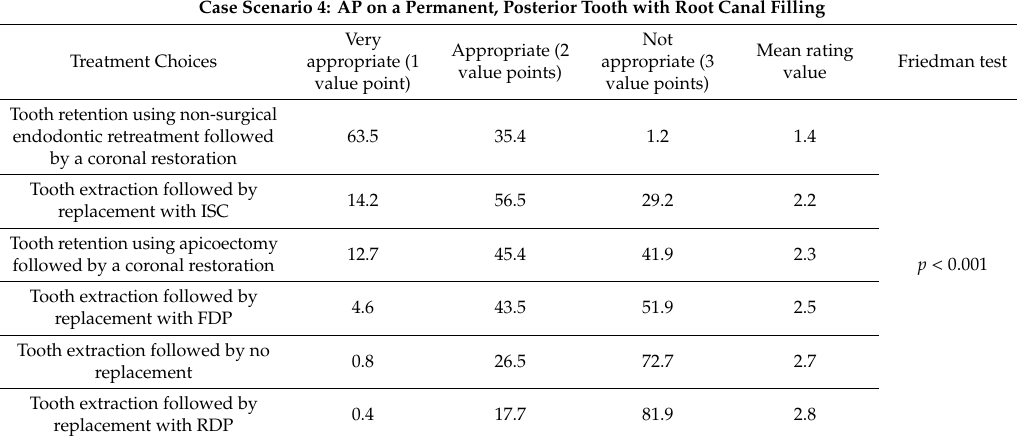
Table 6. Preferences of survey participants regarding case scenario 4 in %, mean rating value and results of the Friedman test comparing all treatment